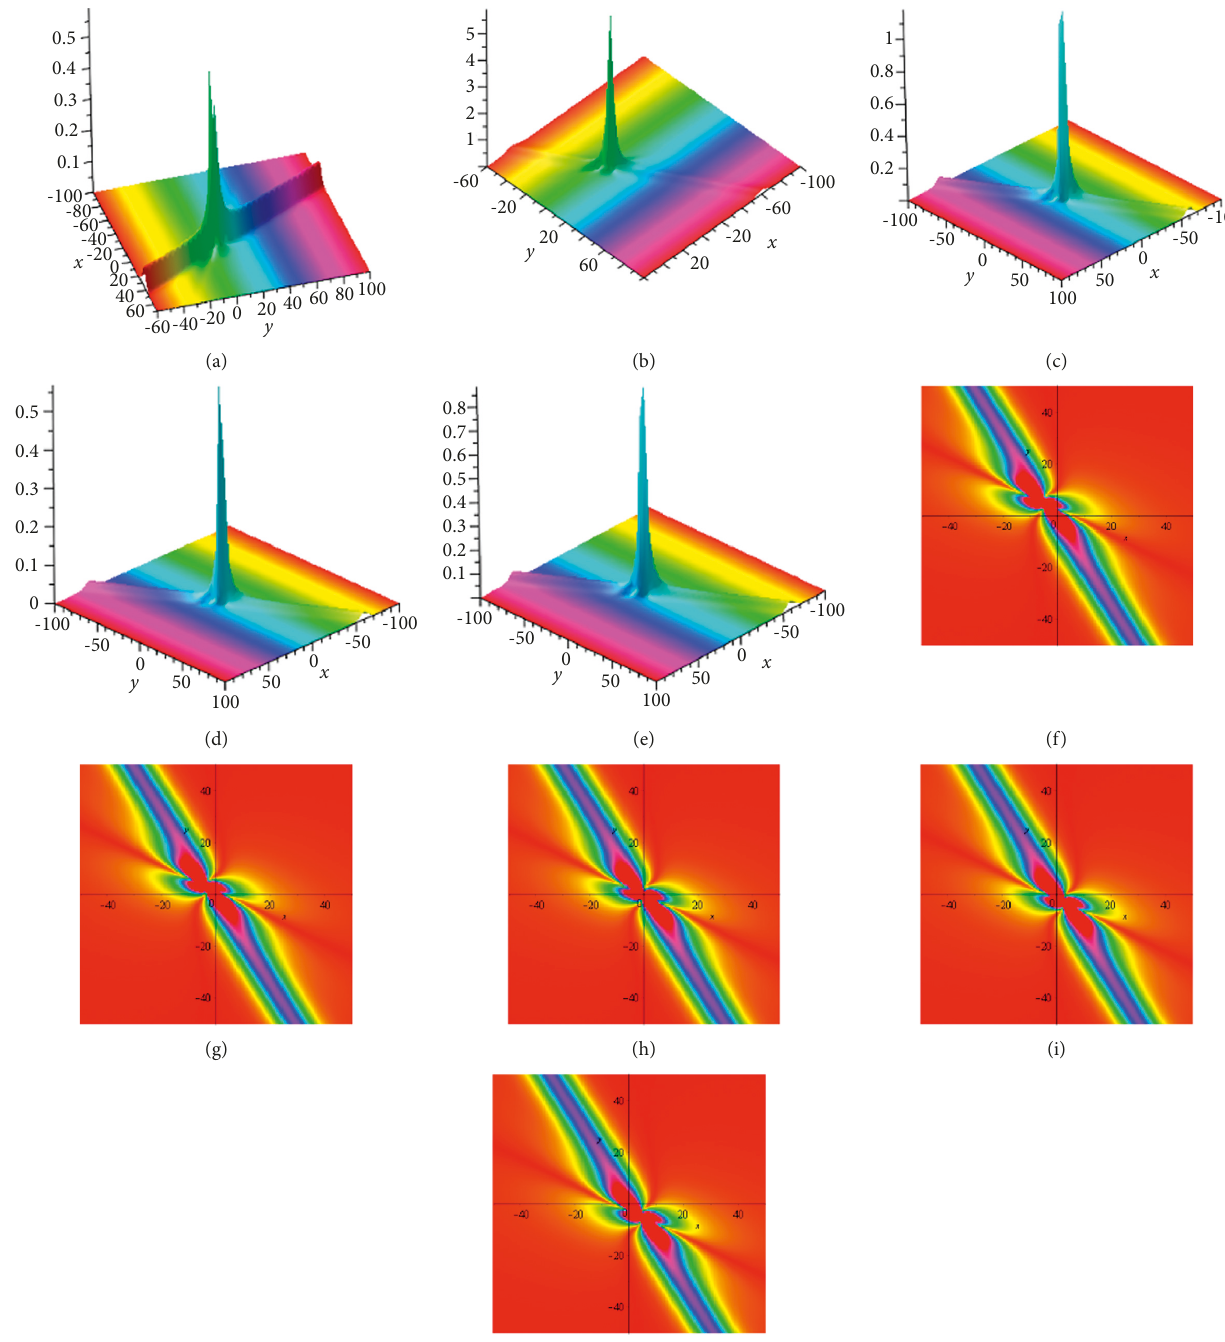
Figure 16: Plots of equation (71) by using c (b) f 2. (c) f 3. (d) f 4. (e) f 5. (f) f 6. (g) f 7. (h) f 8. (i) f 9. (j) f